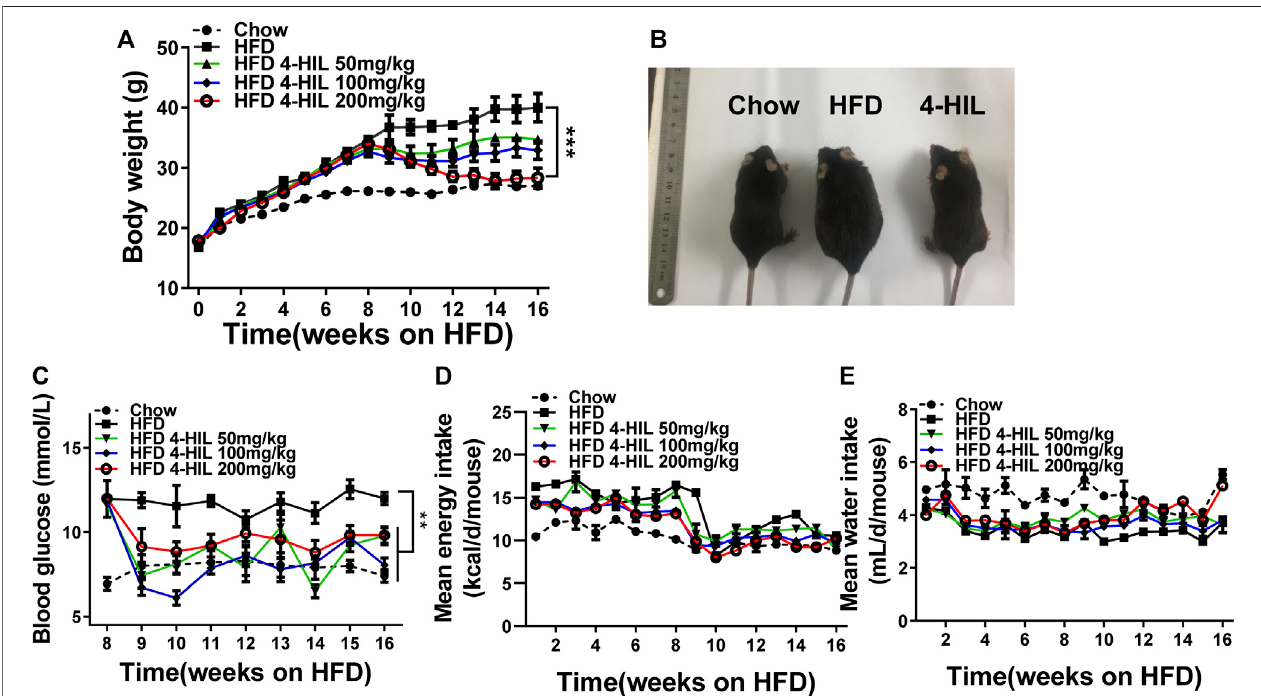
FIGURE1| 4-HILtherapyreversesHFD-inducedobesityandhyperglycemia.MicewerefedwithHFDfor16weeksandbodyweight (A) ,dietconsumption (D) ,and drinking water consumption (E) were recorded every week. 4-HIL intervention was given every day from week 9 and the change of blood glucose was detected every week after administration (C) . (B) Representative photographs of mice in the CHOW group (left) , HFD group (middle) , and 4-HIL (200 mg/kg) group (right) . *, 0.01 < p < 0.05; **, 0.001 < p < 0.01; ***, p < 0.001 ( n (cid:2) 8 for each